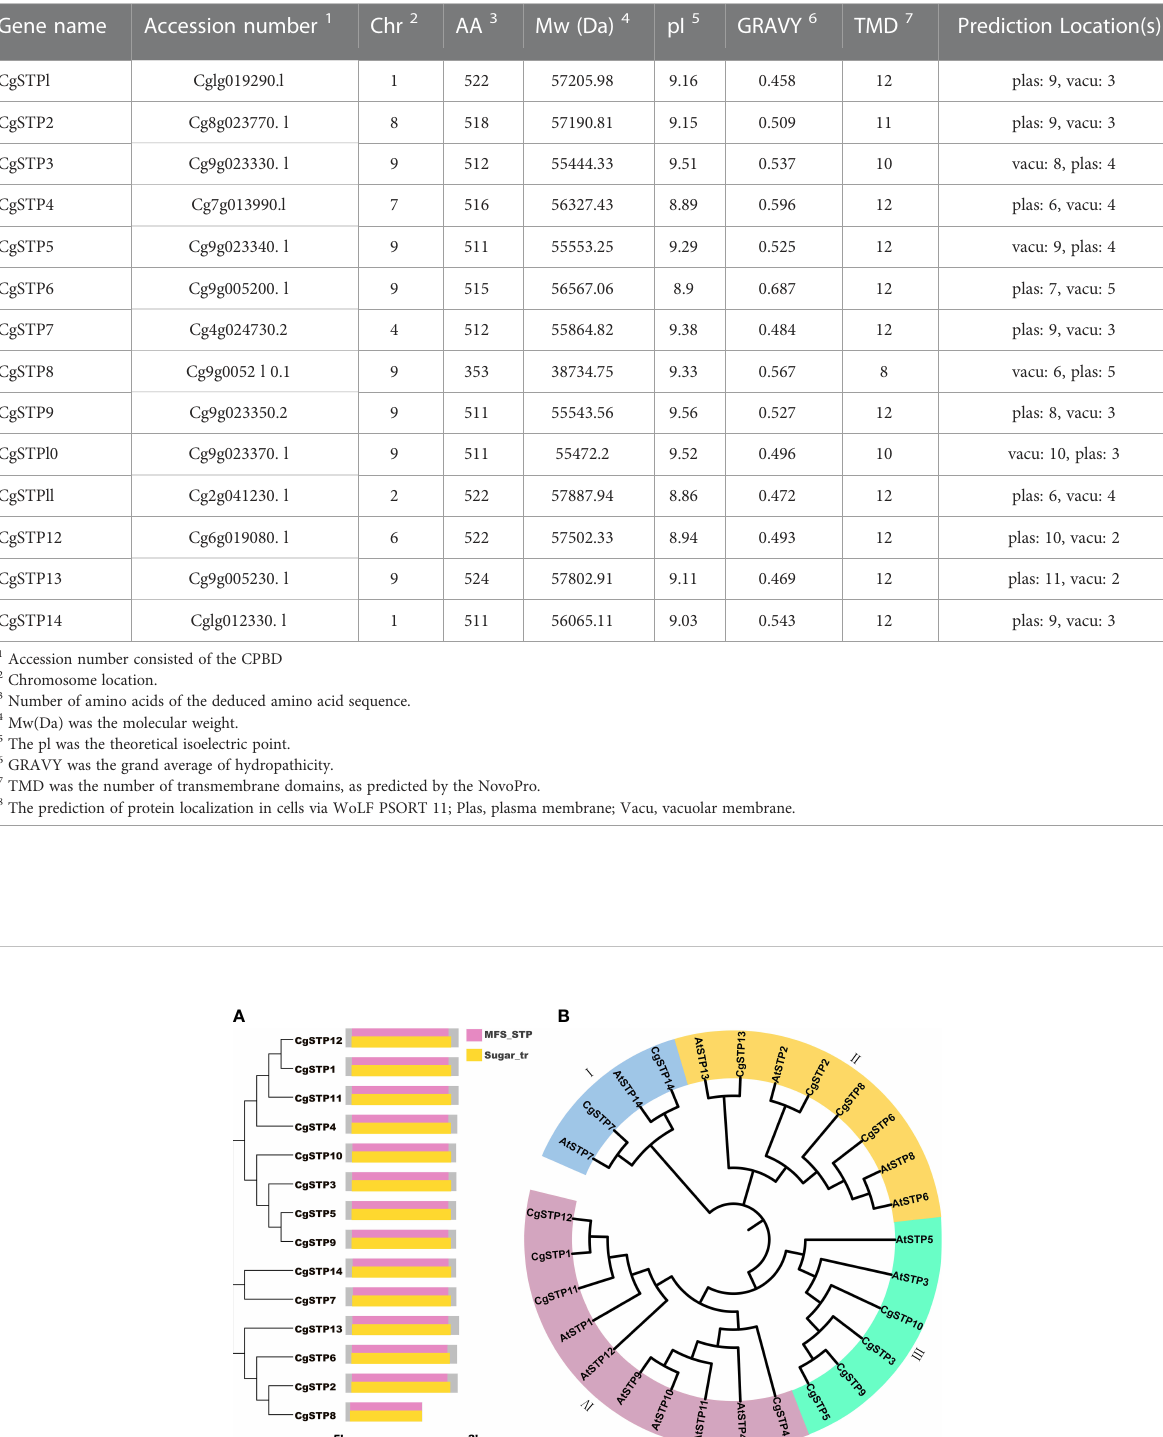
TABLE 1 The information of CgSTP genes.